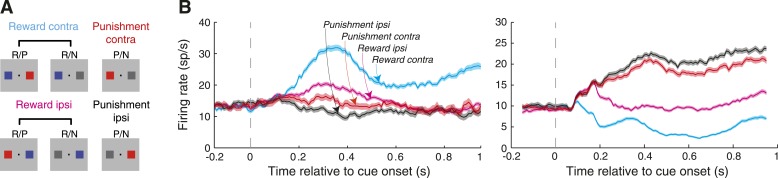
The spatial location of cues predicting rewarding and aversive outcomes modulates amygdala neural activity.(A) Grouping of trial types for the purpose of neural analyses. (B) Example neuron firing rates as a function of time relative to cue onset. Firing rates are plotted for the four trial types (illustrated in A) and shading indicates the standard error of firing rates across trials. For each neuron, spatial-reward selectivity was significant in all time windows (Wilcoxon, p < 0.05); for the neuron on the left, spatial-punishment selectivity was significant in the first two time windows (100–400 ms, 400–700 ms), and the for the neuron on the right, spatial-punishment selectivity was significant in the last two time windows (400–700 ms, 700–1000 ms).